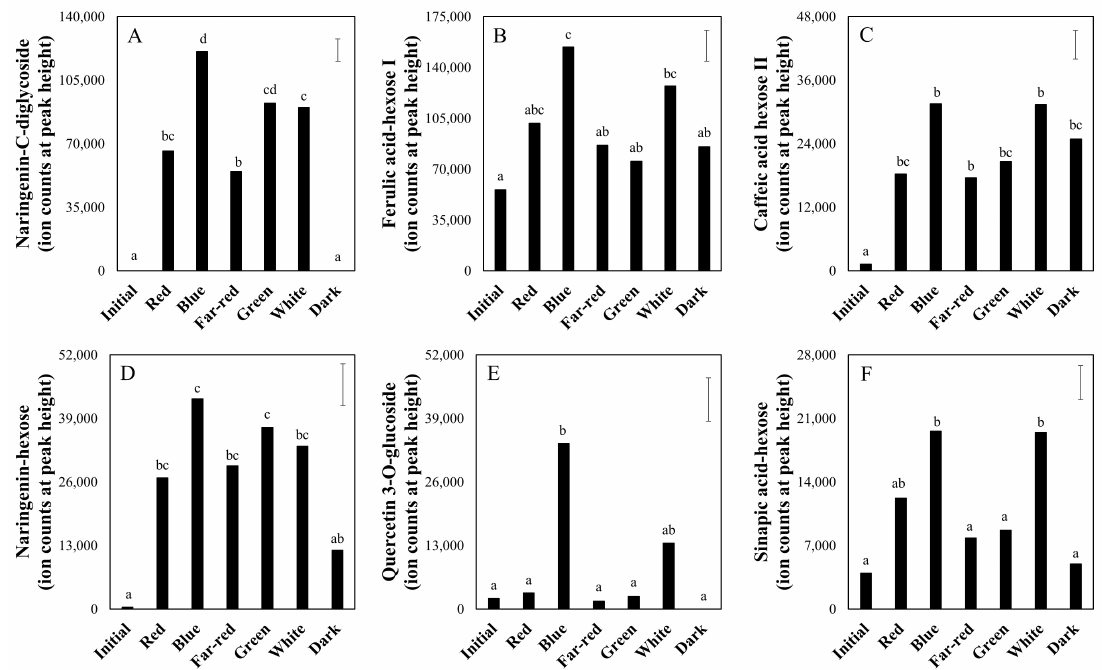
Figure 8. Relative levels of selected metabolites in tomato pericarp from experiment 2, measured by LC-MS. The fruits were treated with white light (background) supplemented with monochromatic red, blue, far-red and green light, and broad-spectrum white light (white) or no light at all (dark) for seven days. Error bars indicate the least significant di ff erence; letters ( A – F ) indicate significant di ff erences between light treatments at α = 0.01, n = 3 (three pools of two fruits each).